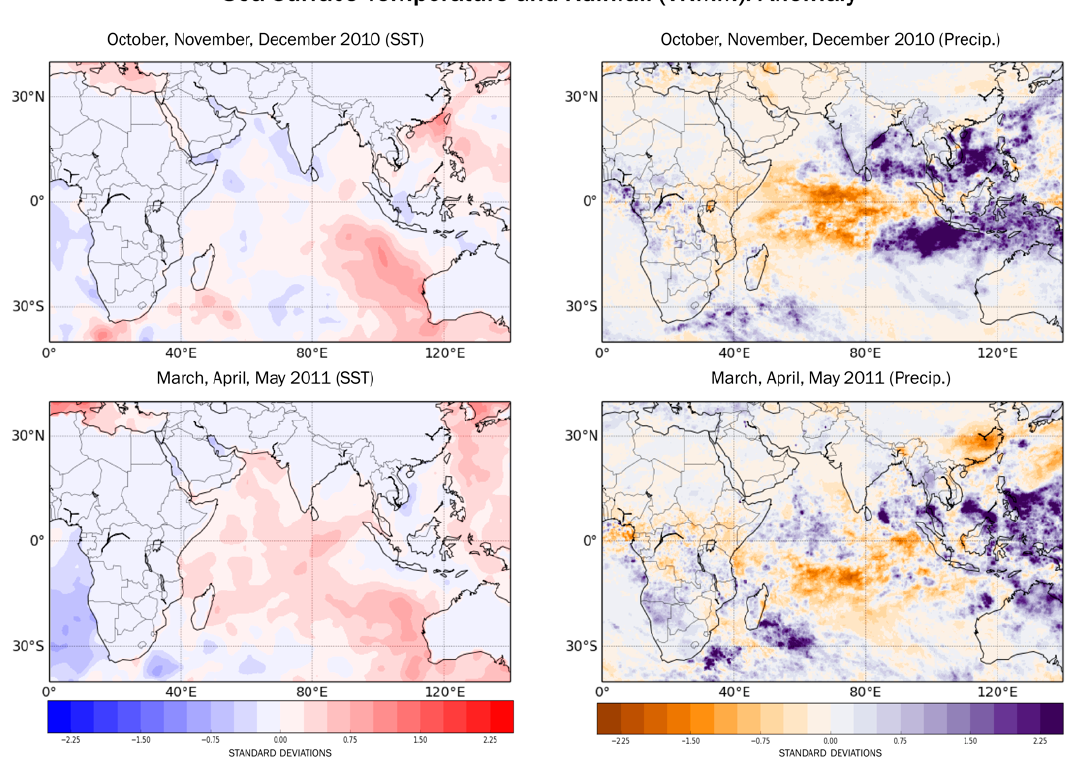
Figure 8. The anomaly of sea surface temperature (HadISST, °C) and rainfall (mm/day) during 2010–2011 East African drought.